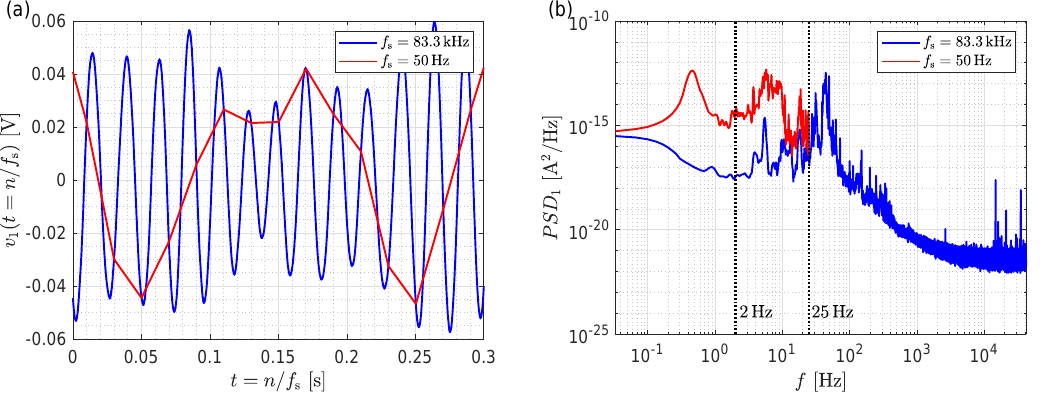
Figure 4. ( a ) Signal of one of the photodiodes at the sensor output in the presence of mechanical vibrations in the setup for a sampling frequency of (a) 50Hz and (b) 83kHz. Only the fast sampling rate reveals the harmonic nature of the oscillations. ( b ) Power spectral density of the photodiode signal. The higher sampling frequency removes the spectral